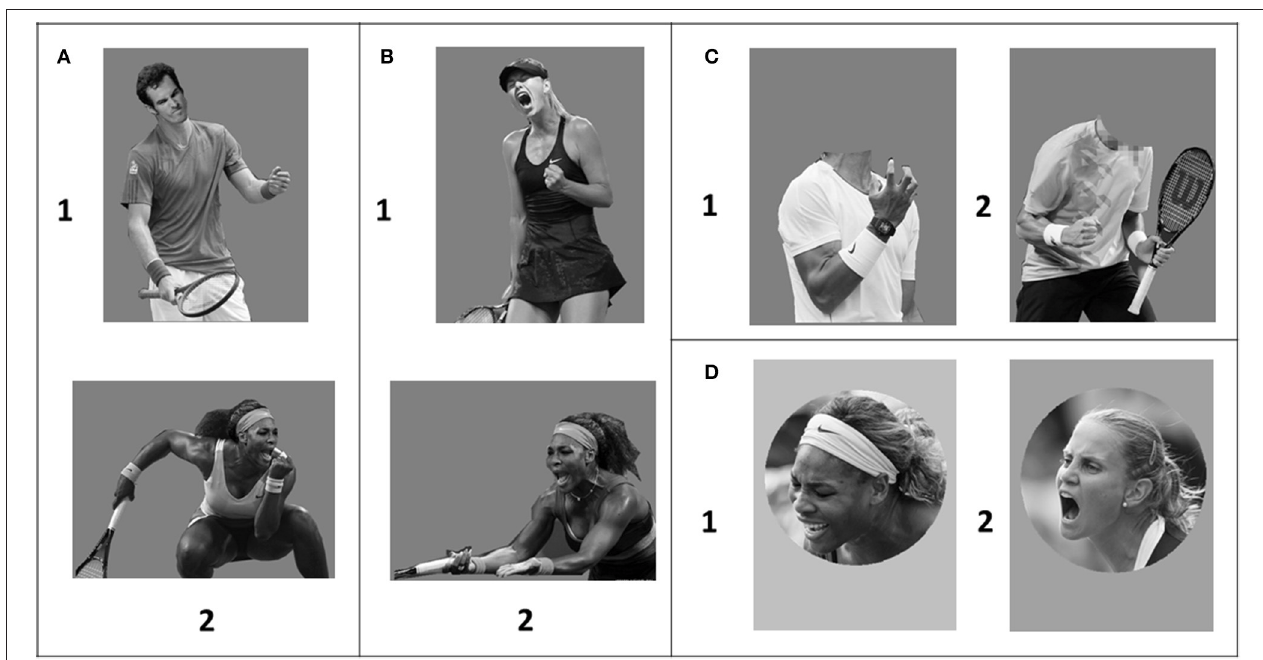
FIGURE 1 | (A) Examples of congruent pictures: (1) losing-face-losing-body; (2) winning-face-winning-body. (B) Examples of incongruent pictures: (1) winning-face-losing-body; (2) losing-face-winning-body. (C) Examples of pictures: (1) isolated winning body; (2) isolated losing body. (D) Examples of pictures: (1) isolated losing face; (2) isolated winning